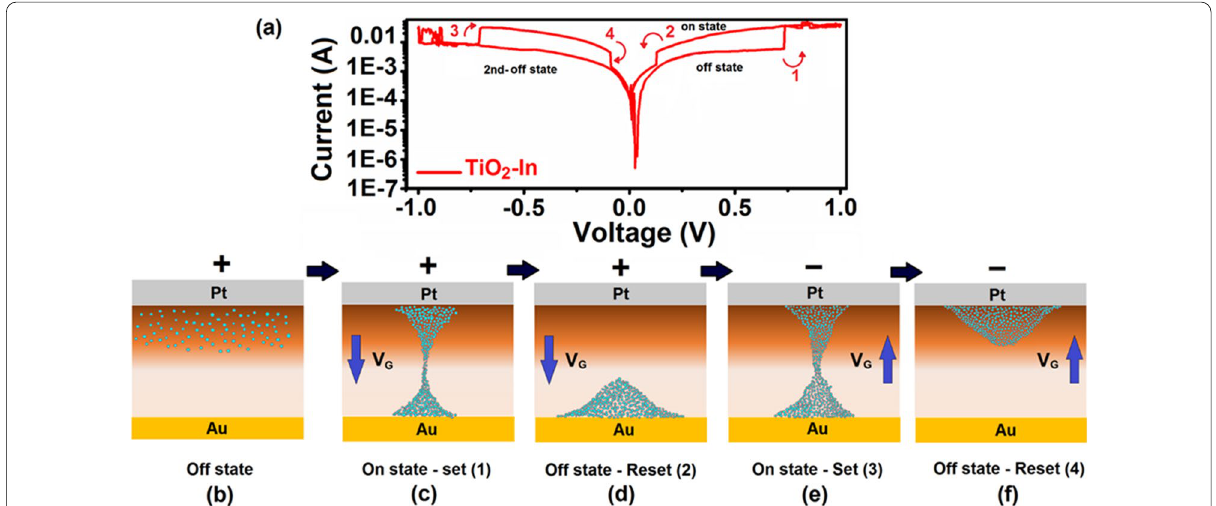
Fig. 17 The Pt/TiO 2 /Ti/Pt stacked crossbar cells: a the SEM top view of (60 nm) 2 cross-point, b The TEM cross-sectional image of 100 nm 2 Pt/TiO 2 /Ti/ Pt device with c its corresponding schematic graph of the plug and disc region in the TiO 2 layer. Reprinted with permission from